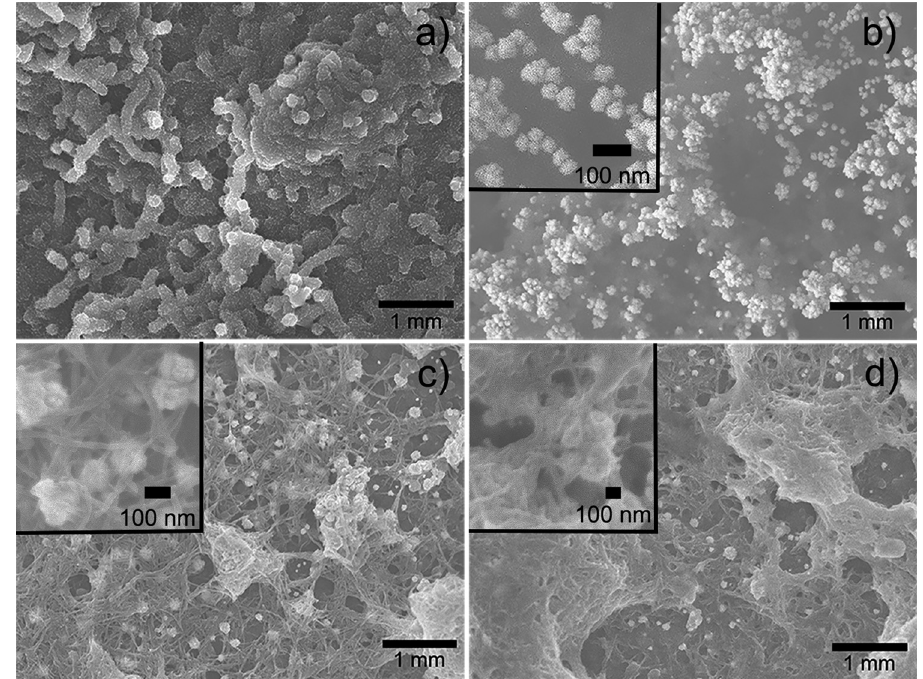
Figure 2: SEM images of ( a ) SPCE/PAni, ( b ) SPCE/PAni/AuNP, ( c ) SPCE/PAni/AuNP/cMWCNT, and ( d )